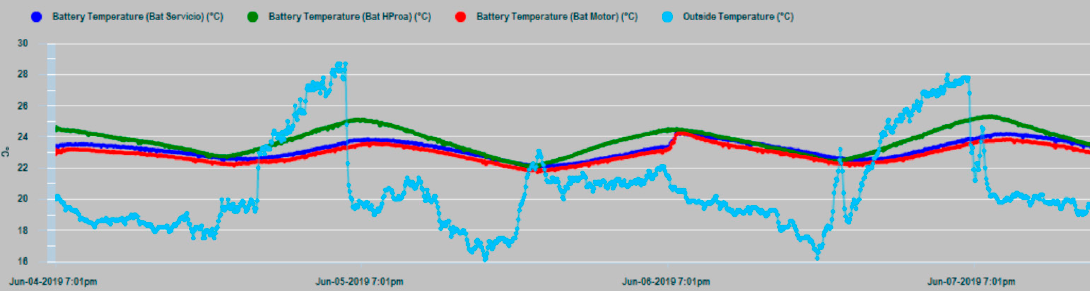
Figure 15. Data series of the external temperature T ex (clear blue) and the three banks inner temperatures: T in Bow thruster (green), T in House (dark blue), and T in Engine (red).